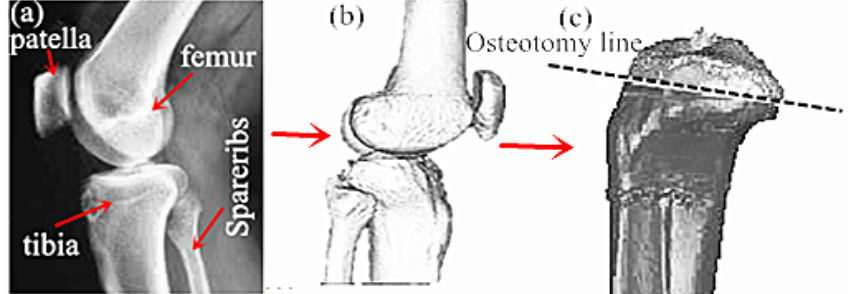
Figure 3. Reconstruction of reverse osteotomy of tibial implants: ( a ) CT image of knee joint; ( b ) Post reconstruction effect; ( c ) Bone cutting surface selection.